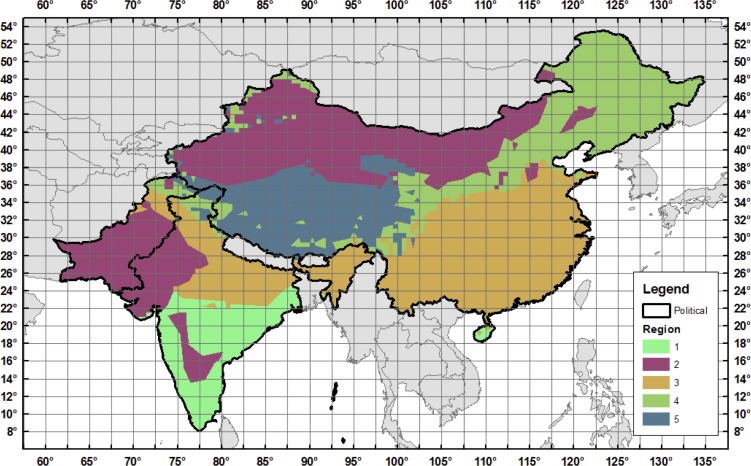
Regions used in the Gaussian Quadrature summary statistics with 2.5° longitude by 2.0° latitude HFD grids.Colored polygons denote the 5 regions used for the Gaussian Quadrature thinning, based on the Koeppen-Geyger Climatic Zones. Black lines are the political boundaries of China, India, and Pakistan.